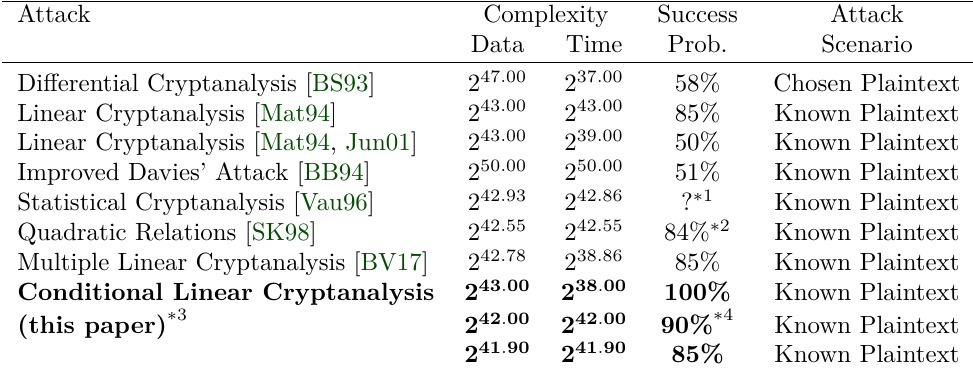
Table 1: Complexity of Attacks Against DES: Time of Analysis ≤ # Known Plaintexts Attack